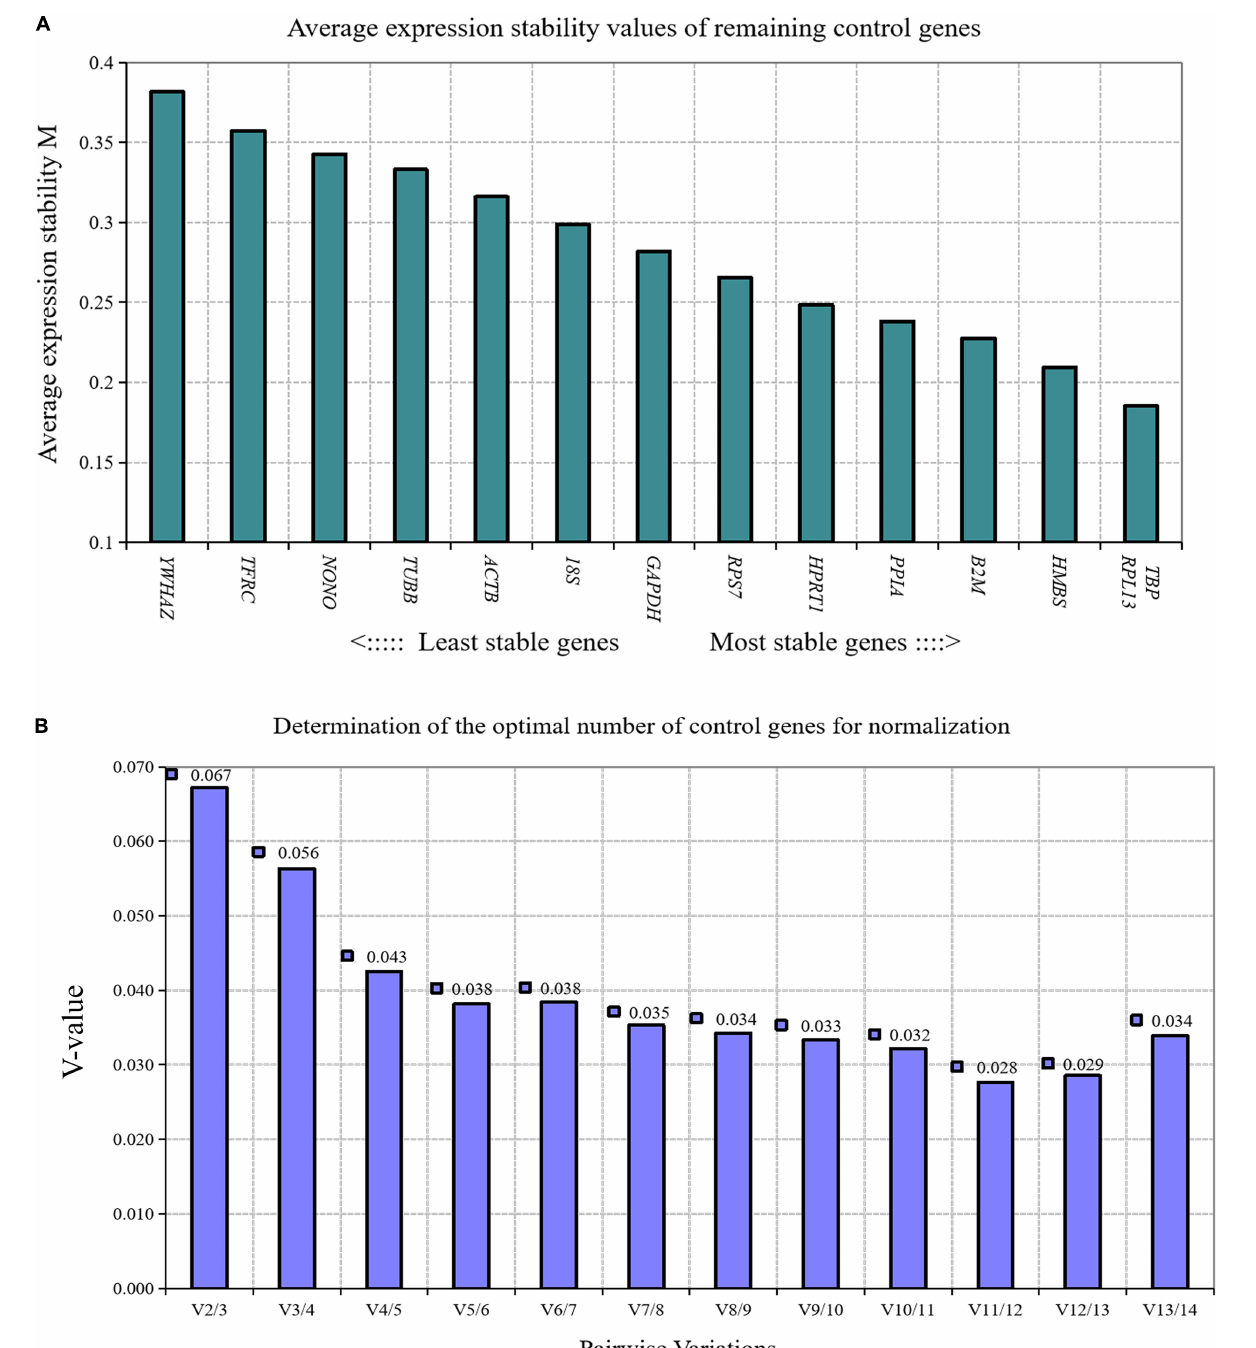
FIGURE 4 | GeNorm analysis of 14 reference genes during chicken primary preadipocyte differentiation. (A) Expression stability analysis. The most stably expressed genes have lower M values. TBP and RPL13 were the two best reference genes; (B) Pairwise variation analysis. Determination of the optimal number of reference genes required for normalization calculated by pairwise variation analysis between normalization factors NF n and NF n + 1 . According to geNorm algorithm, two reference genes were